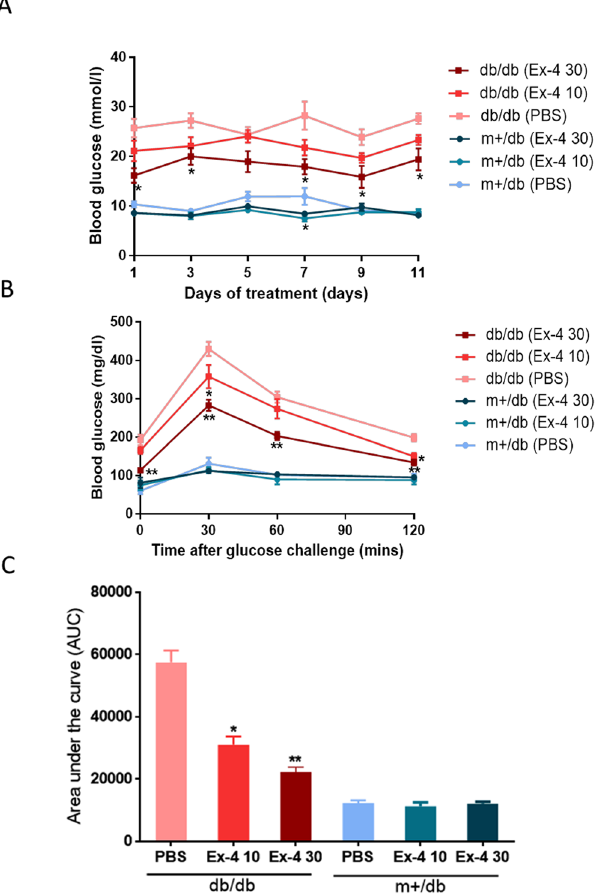
Figure 3. Effects of exendin-4 on blood glucose levels in CUP-1 allografted db/db and db/m + mice. Male db/ db and db/m + mice inoculated with 2 × 10 7 CUP-1 cells were treated with exendin-4 (10 or 30 nM/kg body weight, intraperitoneally) daily for 13 days (n = 10). Random blood glucose was measured at 9:30 am every other day (free access to food) ( A ), and OGTT was performed on day 9 at 9:30 am of exendin-4 treatment after overnight fasting ( B ). Glucose levels expressed as area under the curve (AUC) of glucose level during OGTT are shown in ( C ). Data are expressed as mean ± S.E.M. Ex-4 30 and Ex-4 10: exendin-4 treatment at 30 and 10 nM/ kg body